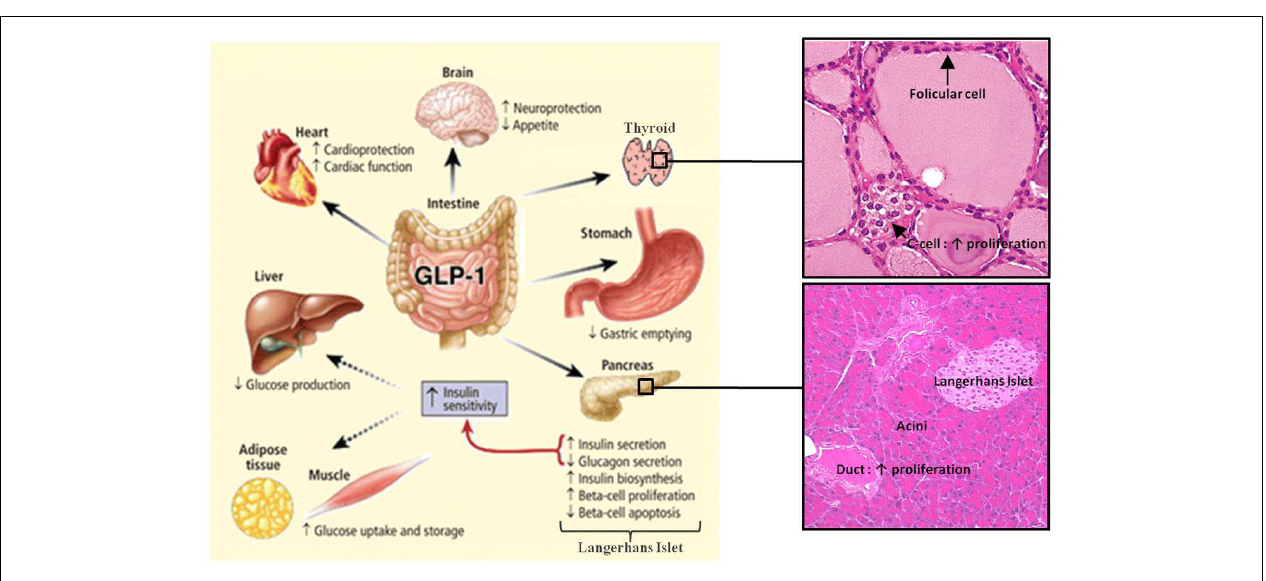
through indirect mechanisms. GLP-1 induces the proliferation of pancreatic duct cells and thyroid C-cells. Reprinted from Gastroenterology (Baggio and Drucker,